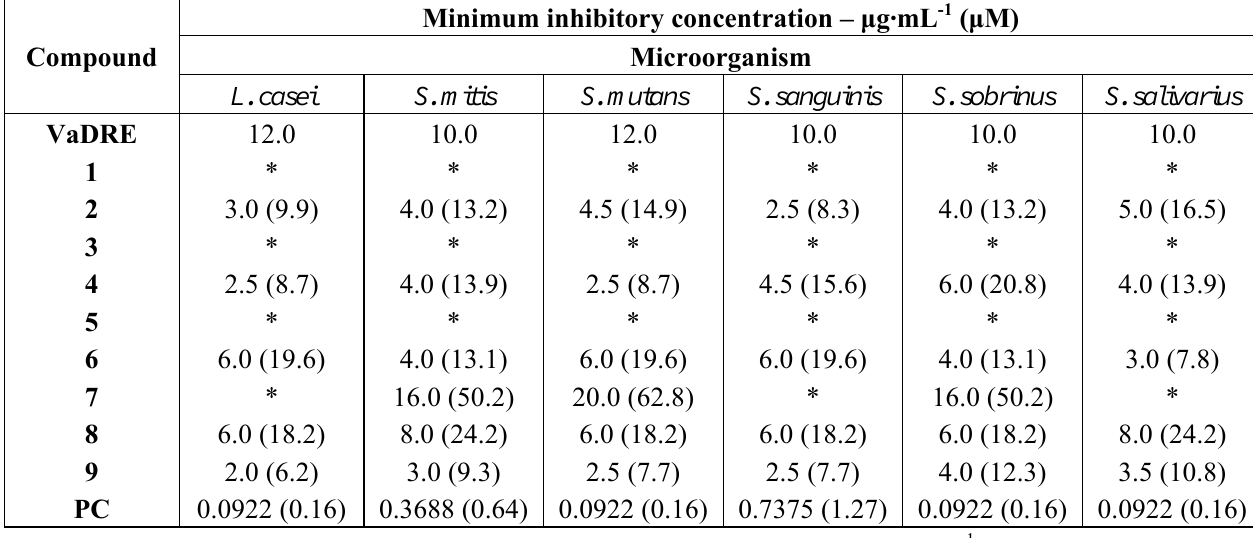
Table 1 . In vitro antibacterial activity (MIC) of the pimarane-type diterpenes against oral pathogens.